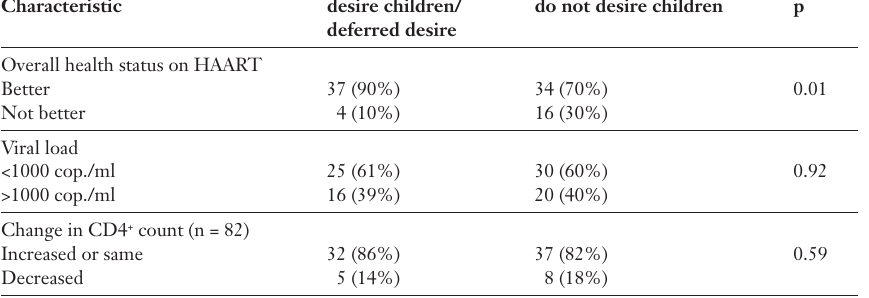
Distribution of study participants (receiv- ing HAART) and their desire for children, by selected charac- teristics (n =